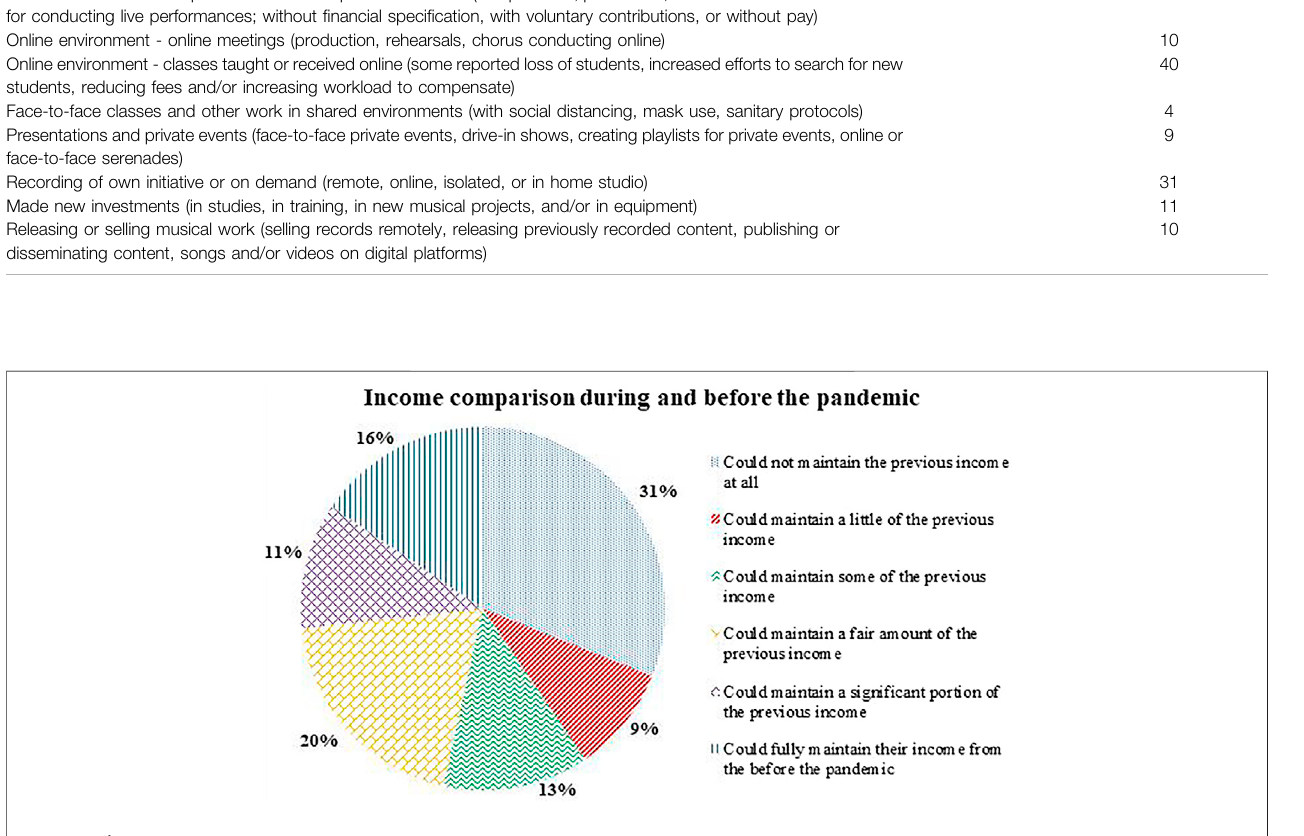
FIGURE 7 | Income comparison during and before the